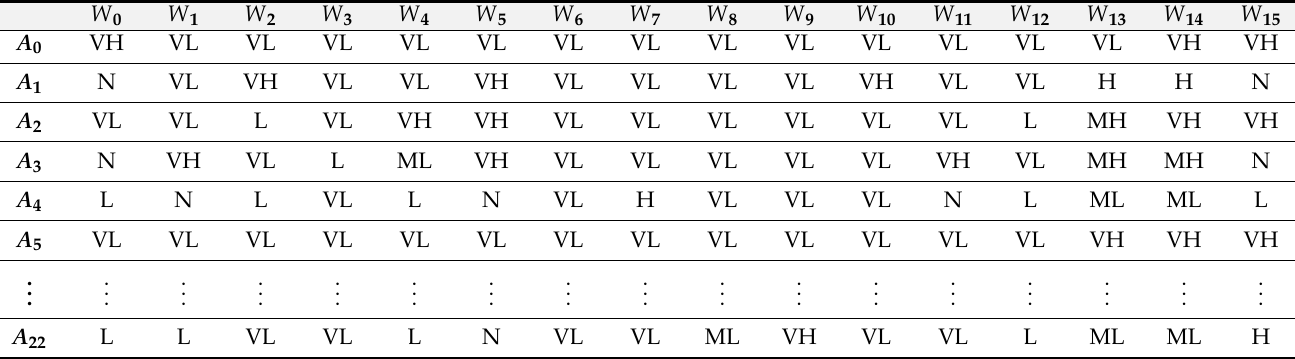
Table 7. Rating the alternative attacker’s actions with respect to the weights of the indicators.